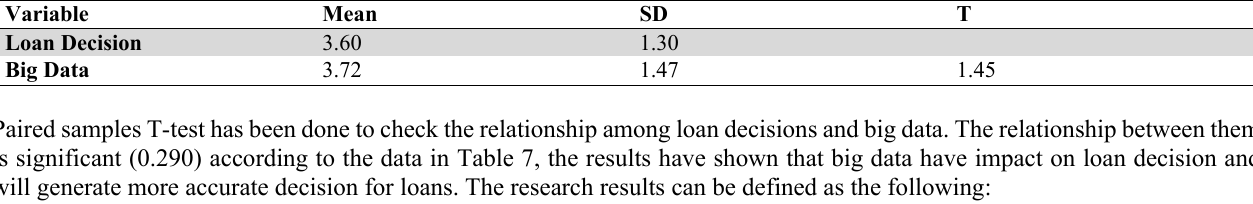
Paired Samples T-test Big Data and loan decision Variable Mean SD T Loan Decision 3.60 Big